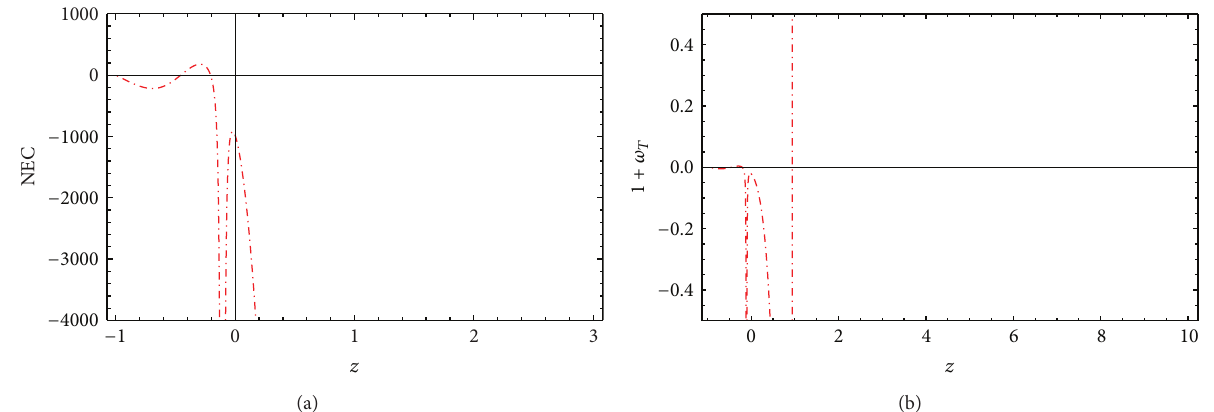
Figure 11: Evolution of NEC and 𝜔 𝑇 for the 𝑓(𝑇) model in HDE for Ω 𝑚0 = 0.315 , 𝐻 0 = 67.3 , and 𝑐 = 0.6 . The left plot shows that NEC is violated and 𝜌 𝑇 + 𝑝 𝑇 = 0 in later times. In the right plot we present the evolution of EoS in 𝑓(𝑇) grvity. These plots favor the Λ CDM era of cosmos.